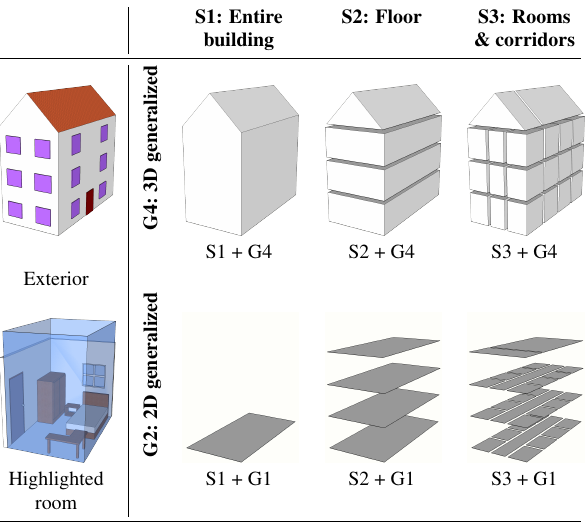
Figure 13. Occupied space with 2D and 3D geometries Building structure and equipment and furnishings Figure